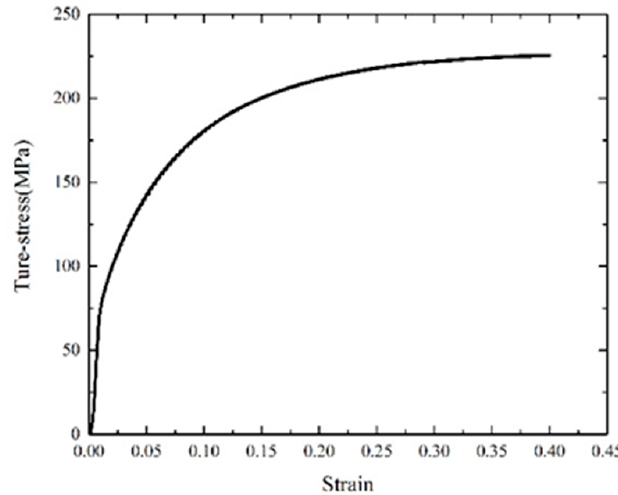
Figure 4. True stress–strain curve of 3A21 aluminum alloy.